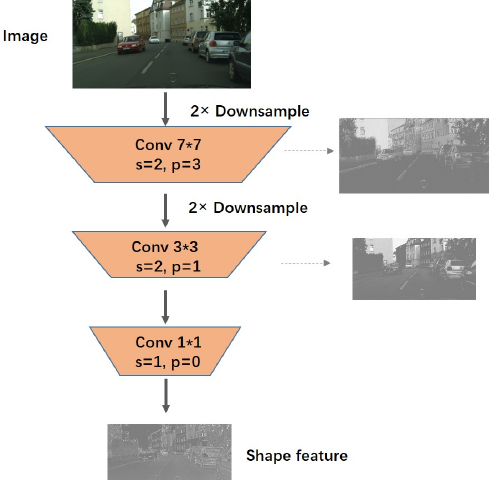
Figure 4. Structure diagram of spatial flow; the right-hand side is the visualization of the feature map after convolution of each layer. After three convolution layers, a quarter-size feature map containing spatial relations is obtained, as shown at the bottom of the